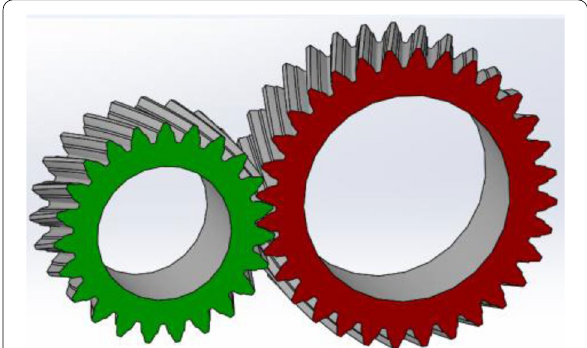
Figure 1 Double involute gear transmission